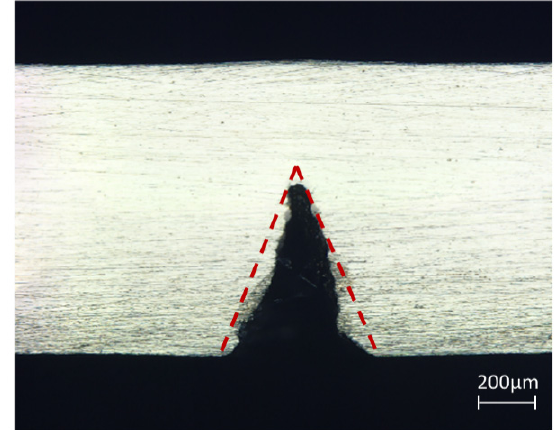
Figure 6. Cut section morphology.